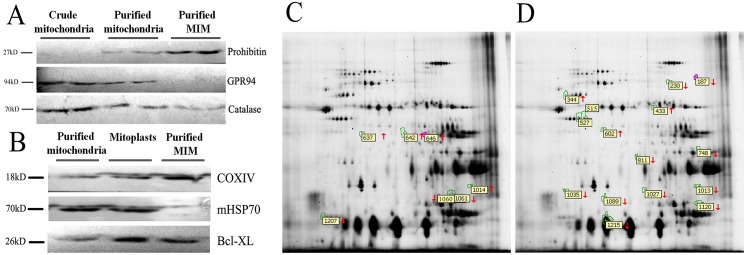
Proteomic analysis of myocardial mitochondrial inner membrane (MIM).(A) and (B) MIM purification from rat myocardial mitochondria; (C) Differential protein spots between DZ 0w group and DZ 4w group in the master gel; (D) Differential protein spots between DZ 0w group and DZ 6w group in the master gel.